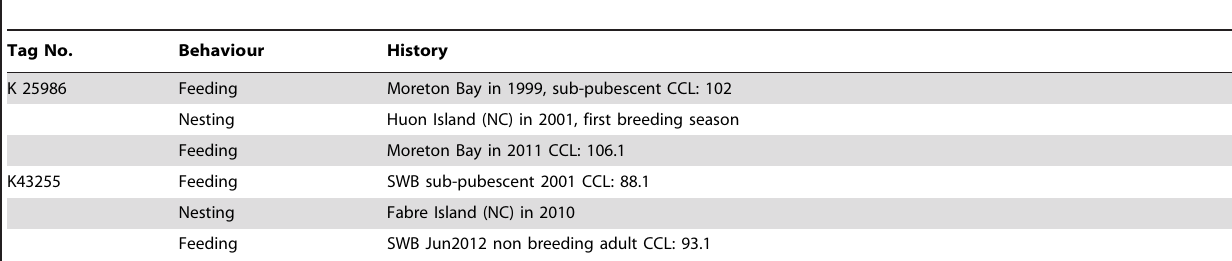
Table 1. Case histories illustrating fidelity of C. mydas to feeding areas in Coral Sea.